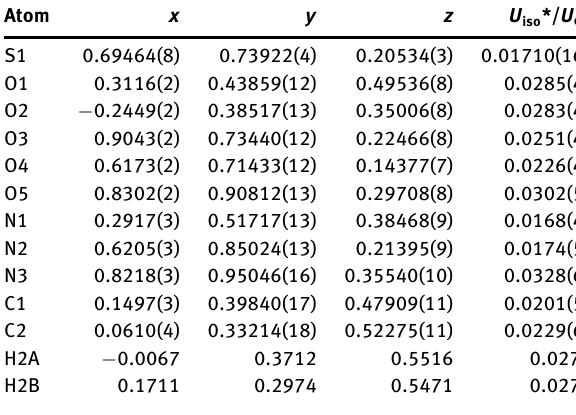
Table 2: Fractional atomic coordinates and isotropic or equivalent isotropic displacement parameters (Å 2